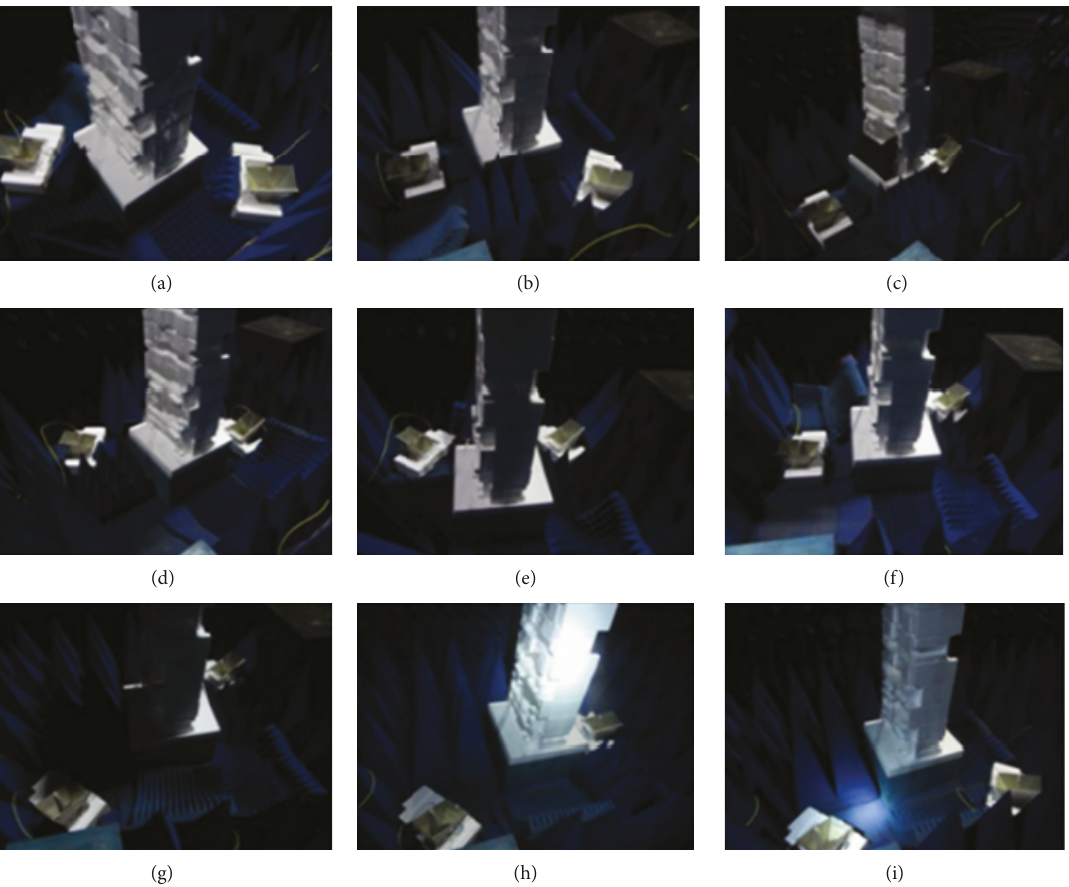
Figure 12: The layout of (a) T1 +R3, (b) T2 +R3, (c) T2 + R2, (d) T1+ R2, (e) T1 +R1, (f) T2 +R1, (g) T3 + R1, (h) T3 + R2, and (i) T3 +R3 of the 3 ∗ 3 MIMO antenna array (T stands for transmitting antenna, R stands for receiving antenna, and + stands for combination). Table 4: Location parameters of transmitting antennas and receiving antennas in the spherical coordinate system.